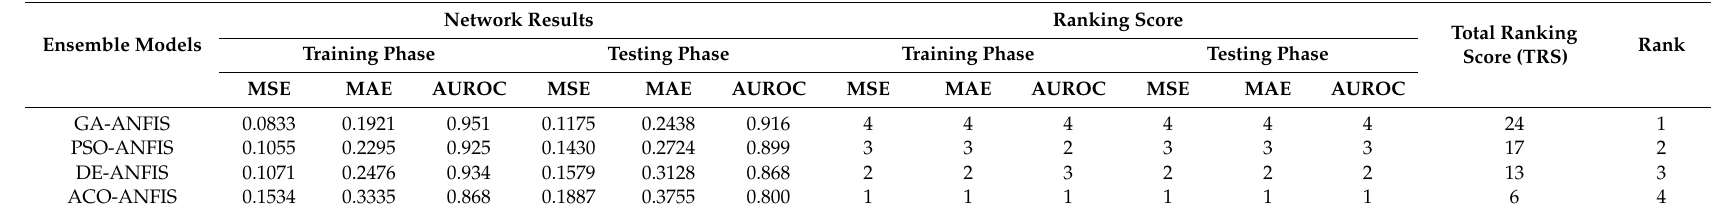
Table 3. The ranking system based on the results of the spatial prediction of landslide